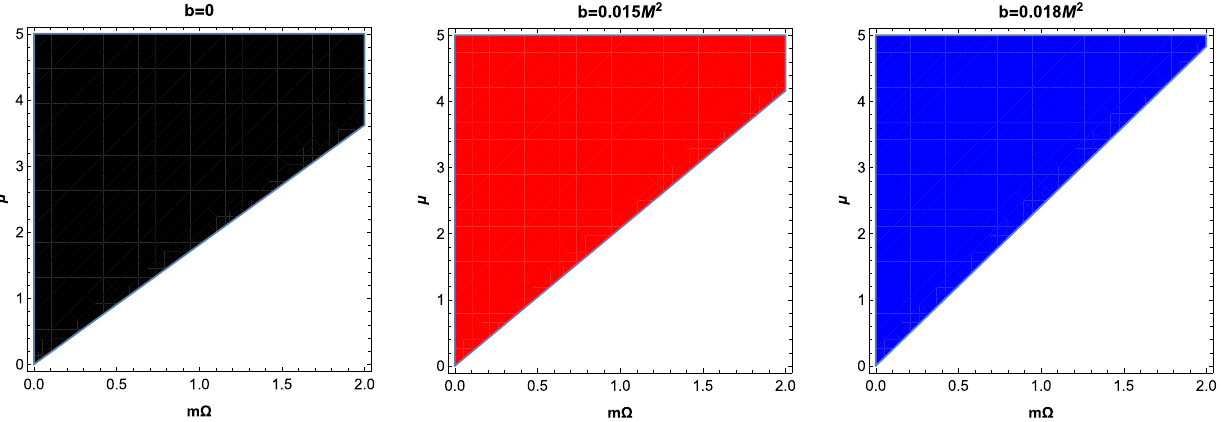
Fig. 10 Parameterspace( m (cid:4) - μ )formassivescalarfieldwherecoloredarearepresentsregionwithstabledynamicsandnon-coloredarearepresents region with unstable dynamics. Here ˆ a = 0 . 51M and l = 0 .